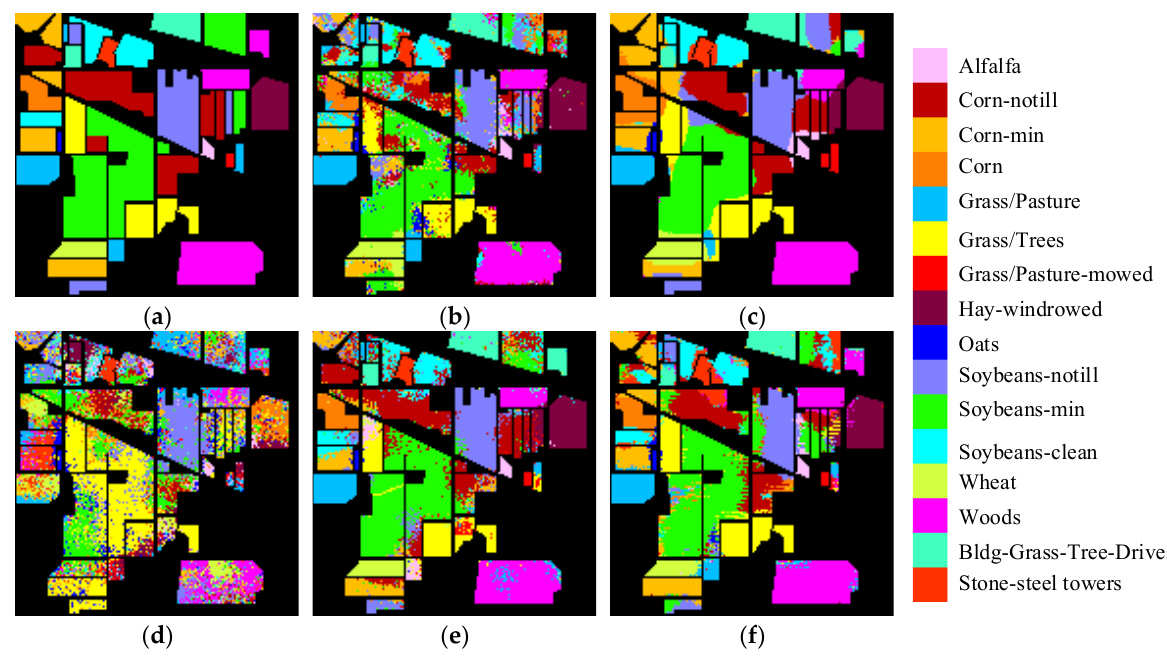
Figure 15. Classification maps of different model (training sample = 10) on the IP dataset. ( a ) Ground-truth map. ( b ) HybridSN. ( c ) MAPC. ( d ) MFFN. ( e ) DC-CNN. ( f ) DSEN.